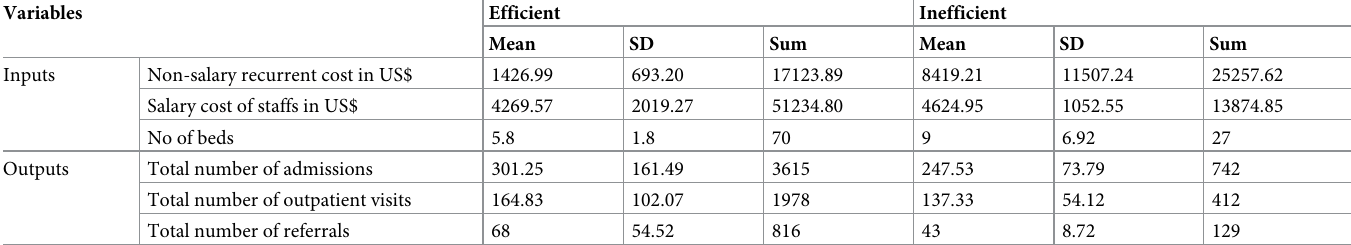
Table 2. Inputs for and outputs of neonatal health service provision among efficient and inefficient primary hospitals in three zones of Northwest Ethiopia, 2021 (N = 15 DMUs). Variables